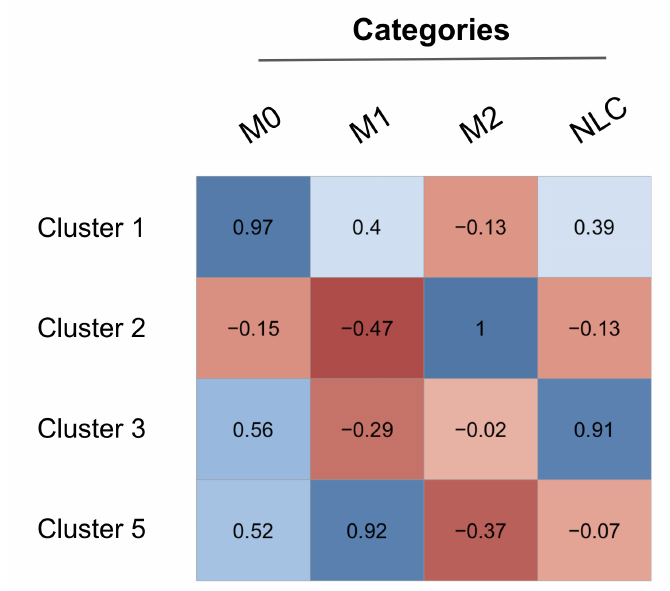
Figure 5. Matrix of Pearson correlation between M0, M1, M2 and NLC categories and the 4 biologically relevant